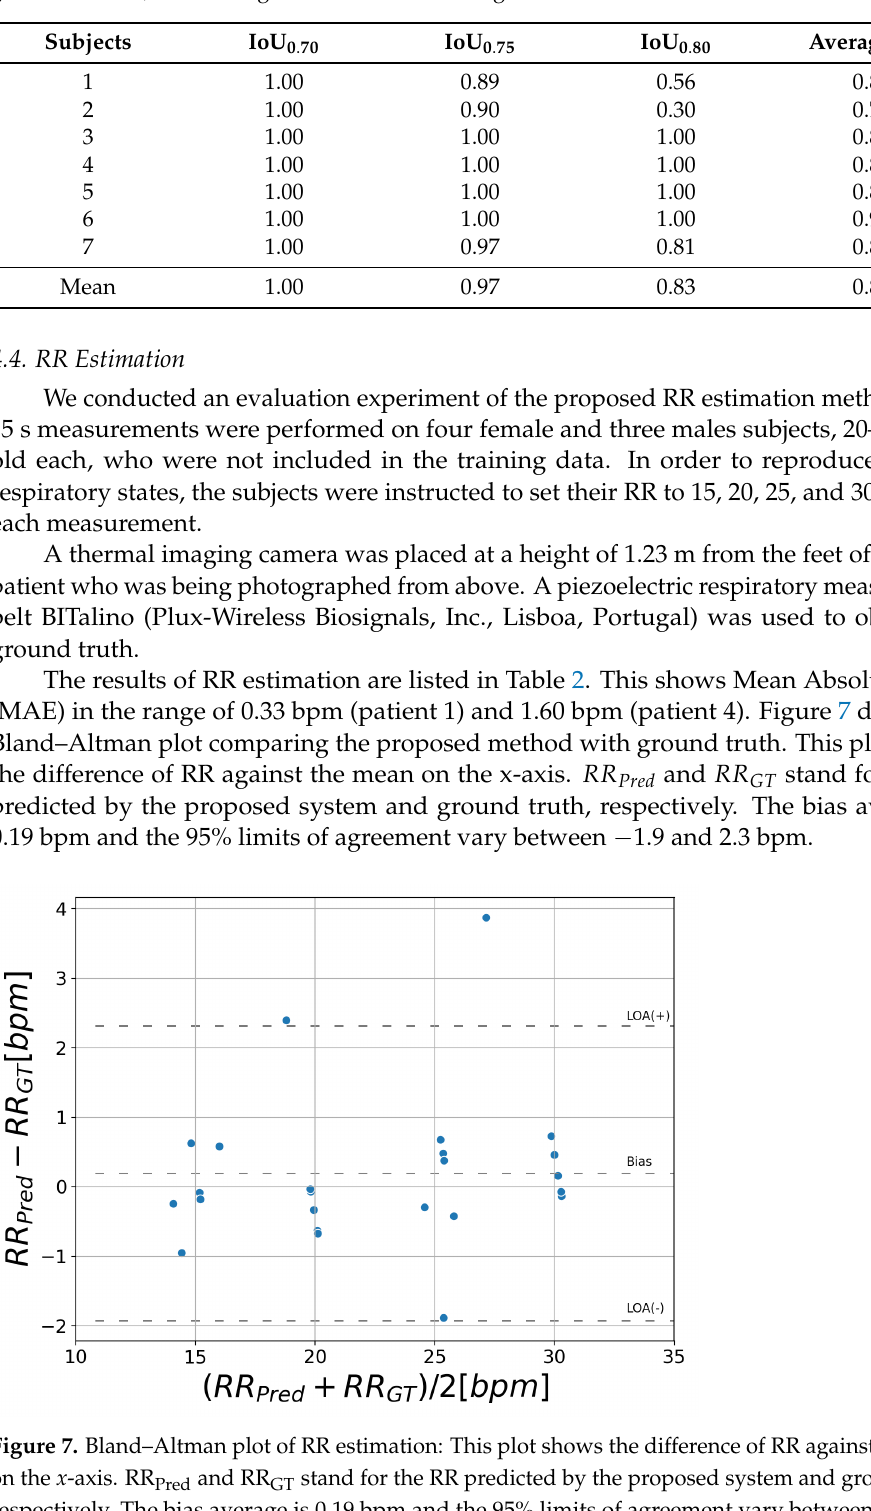
Table 1. Detection result: IoU 0.70 , IoU 0.75 , and IoU 0.80 indicate the ratio of detection results whose IoU is higher than a certain value. For example, IoU 0.70 shows the fraction of detection whose IoU is greater than 0.7, and Average IoU shows the Average of IoU of detection results.